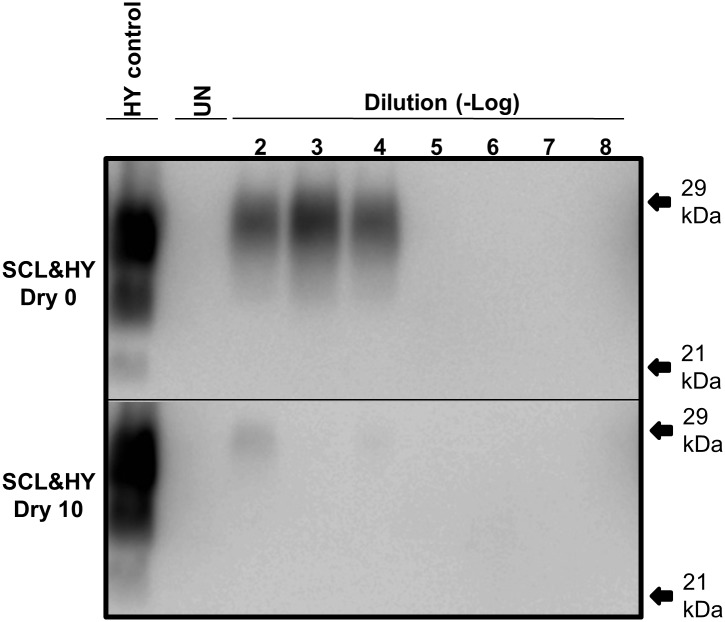
Reduced PMCA conversion coefficient of SCL-HY after repeated cycles of drying and wetting.Western blot of PMCA amplification of 10-fold serial dilutions of standardized SCL-HY PrPSc before (Dry 0) or after 10 (Dry 10) rounds of drying and wetting. Samples in replicates (n = 3) were tested. Migration of 29 and 21 kDa molecular weight marker is indicated on the right of the Western blot.